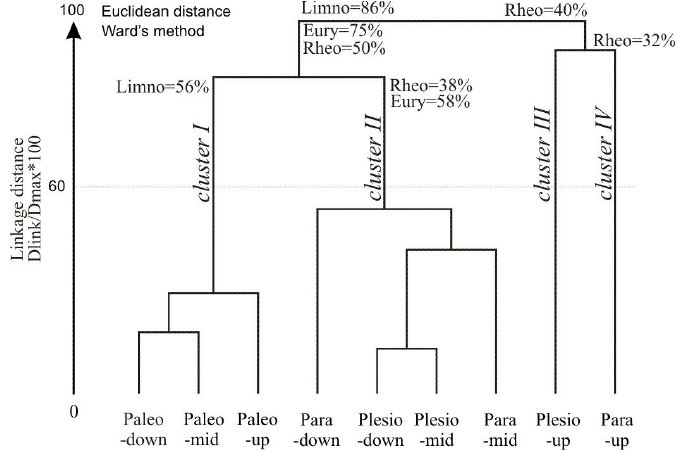
Figure 5. Dendrogram of Hierarchical Cluster Analysis (HCA) for upstream (-up), middle parts (-mid) and downstream arms (-down) of floodplain lakes types based on % of fish abundance data, obtained by using the Ward’s method as linkage rule and Euclidean distance as a metric for distance calculation. Statistically significant clusters when (D link /D max ) · 100 < 60.